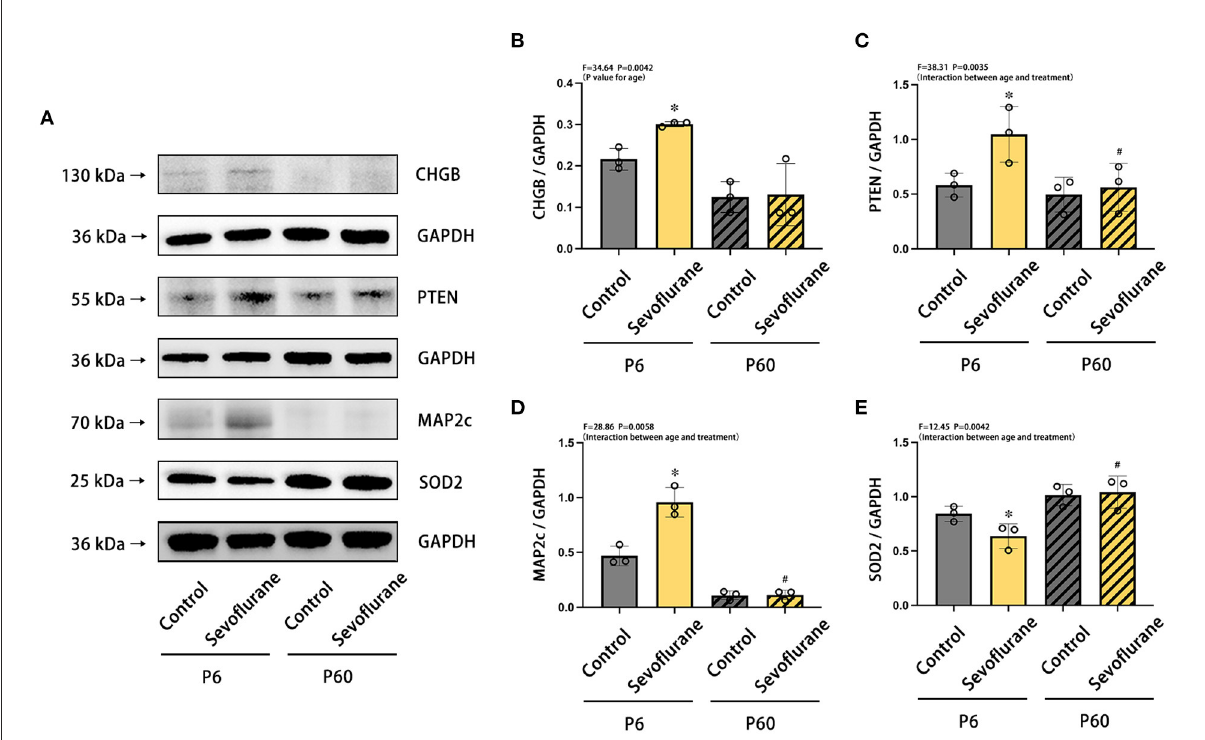
FIGURE5 Differences in the expression of CHGB, PTEN, MAP2c, and SOD2 proteins in the cerebral cortex of neonatal and adult mice after multiple exposures to sevoflurane anesthesia. (A) Differences in the relative expression levels of (B) CHGB, (C) PTEN, (D) MAP2c, and (E) SOD2 in mice cerebral cortex at various ages and treatments. n = 5 mice/group. Results are expressed as mean ± standard deviation (SD). * P < 0.05 vs. P6 + control group, # P < 0.05 vs. P6 + Sevoflurane group. P6, postnatal day